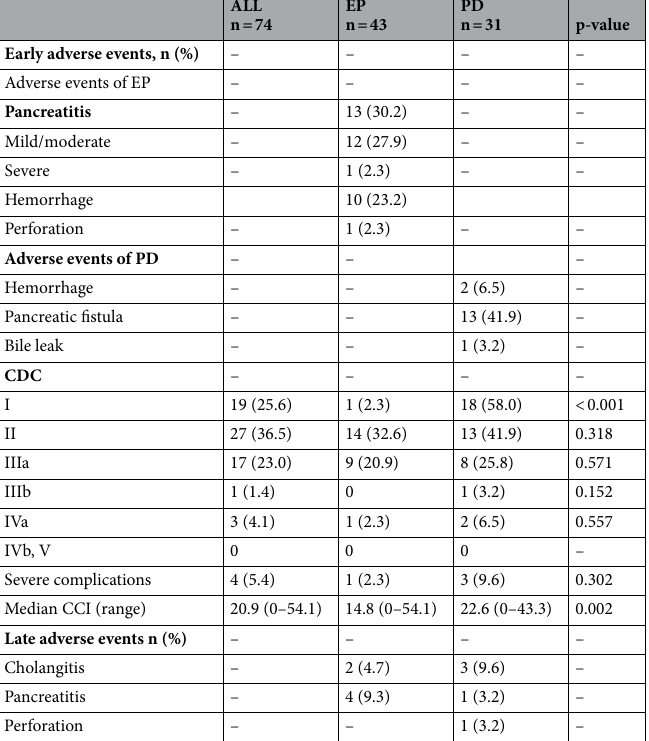
Table 6. Post-procedural complications. CDC Clavien–Dindo classification, CCI comprehensive complication index, EP endoscopic papillectomy, PD